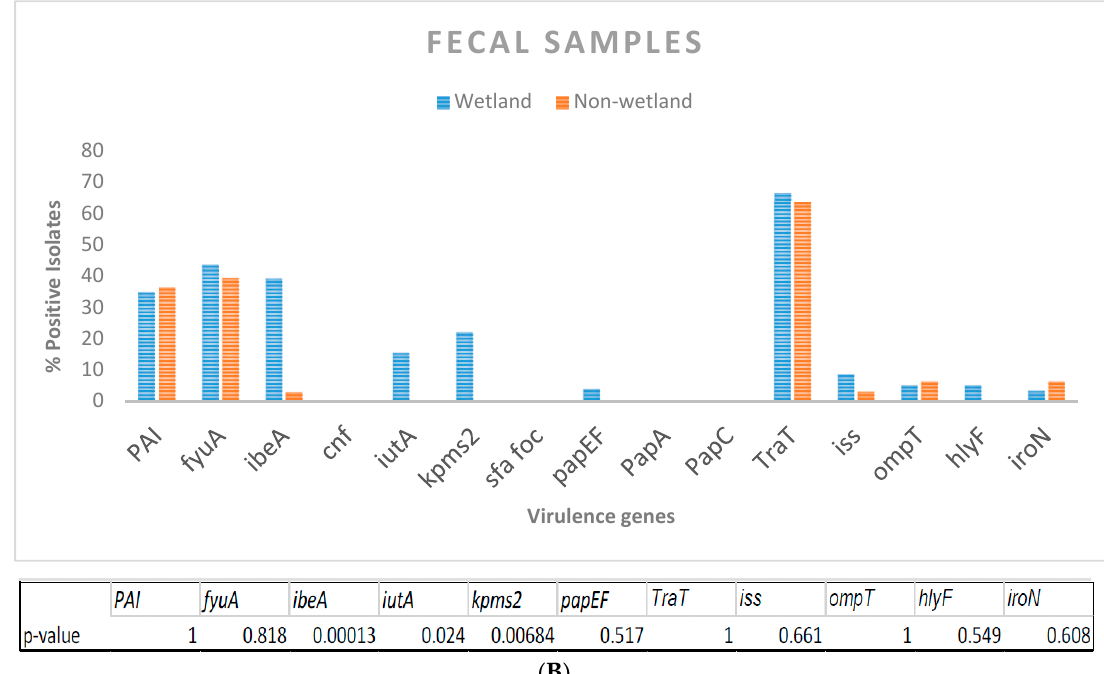
Figure 2. ( A ) Presence of virulence genes in E. coli isolated from wetland water ( n = 134) and crow feces ( n = 71) was determined by 4 multiplex PCRs with primers targeted to 15 genes. Table indicates significant di ff erence in virulence gene abundance between water and fecal isolates. ( B ) Percentage of virulence genes in wetland fecal isolates ( n = 71) compared to that present in isolates from 3 non-wetland locations ( n = 34). p -values are indicated below.